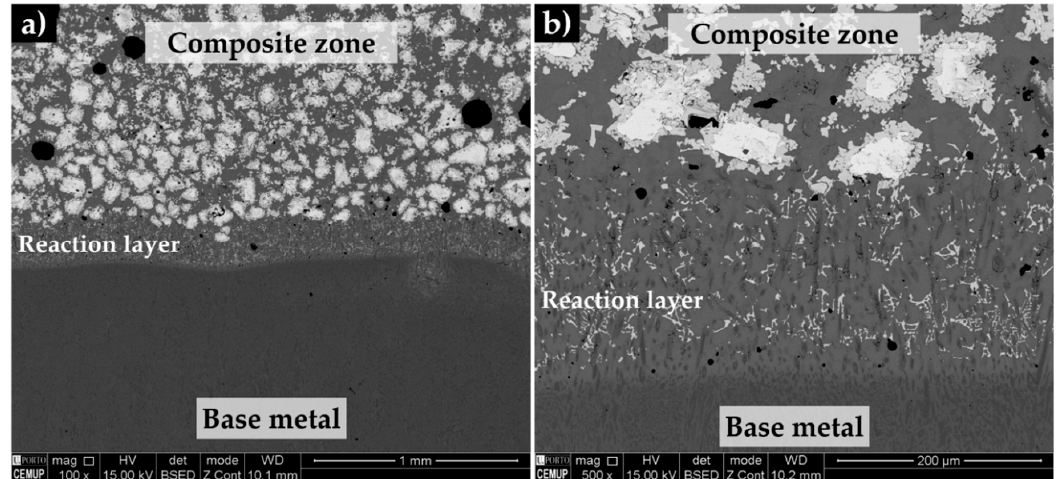
Figure 13. SEM-BSE images of the microstructure of the reinforced specimen showing the base metal and composite zone ( a ) and evidencing the reaction layer ( b ).